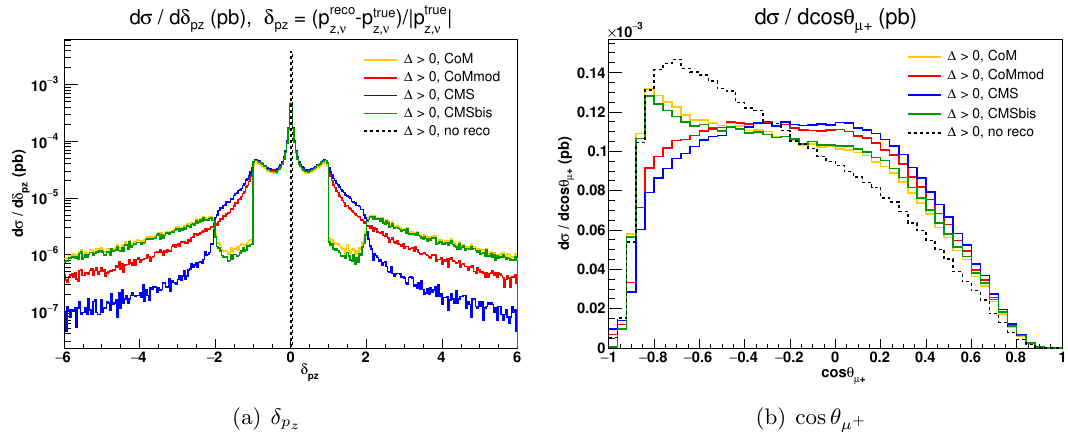
Figure 21 . W + Z scattering: neutrino reconstruction, (cid:1) > 0. Distributions in (cid:14) p